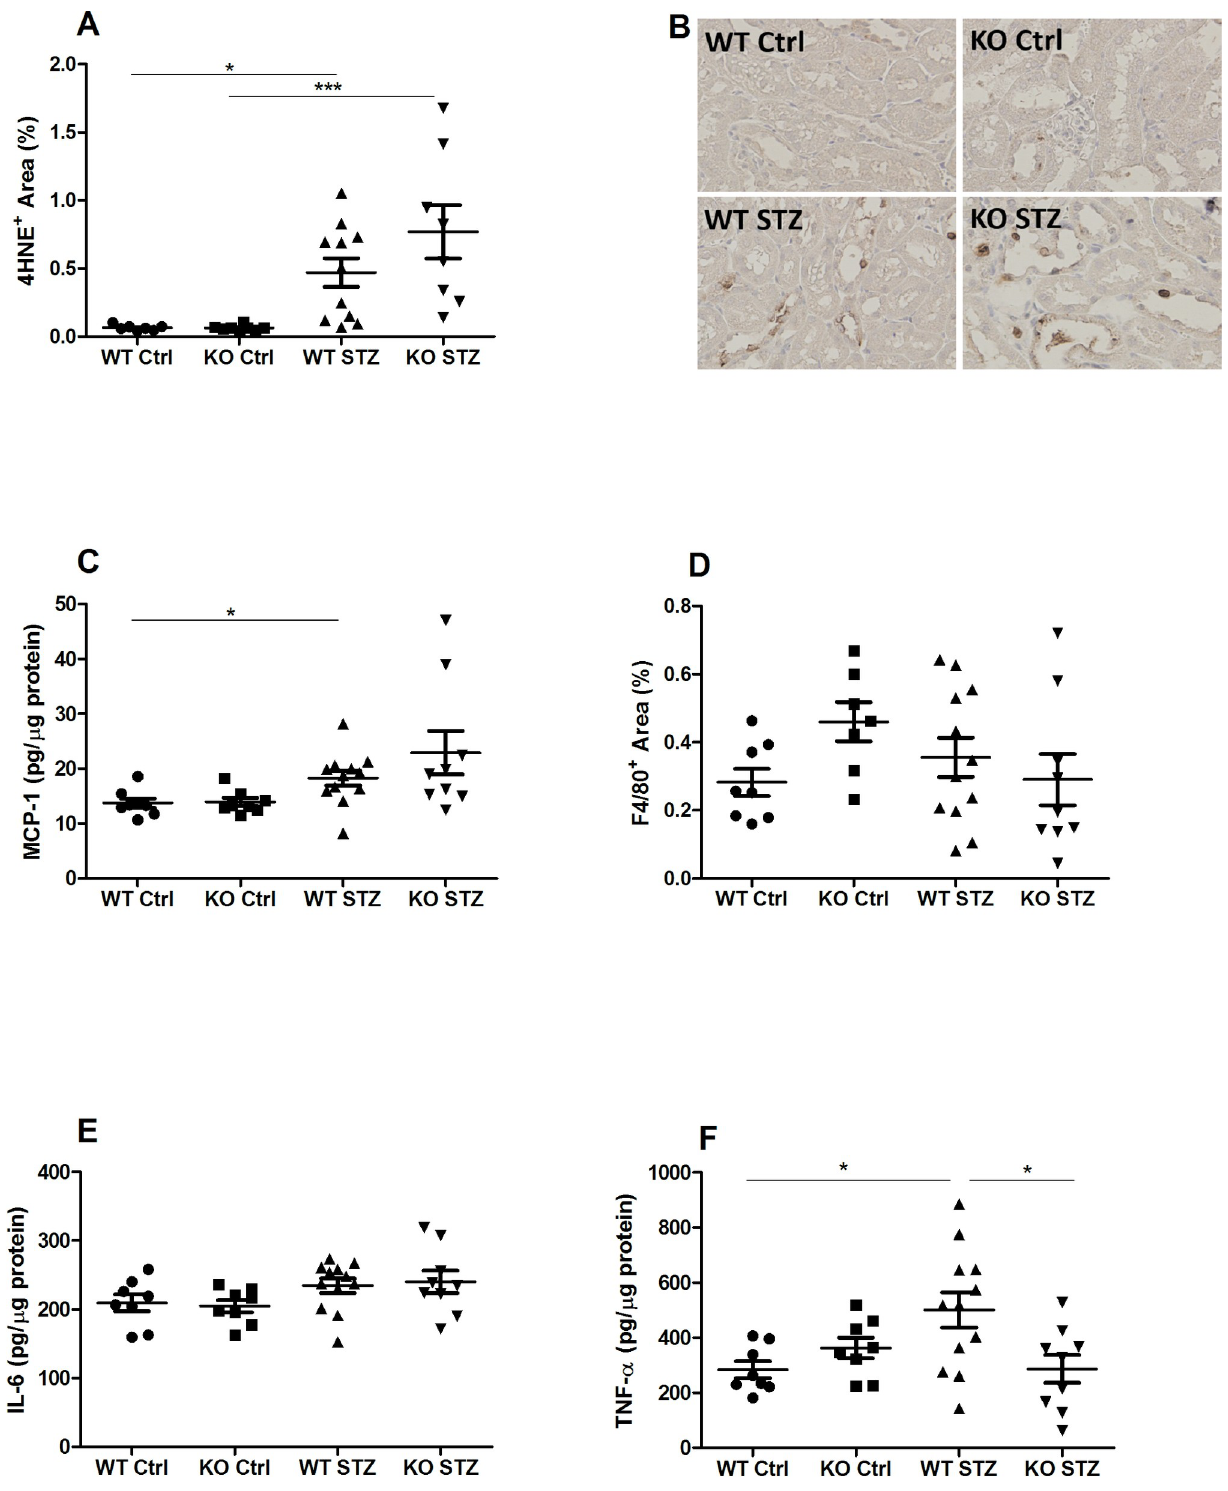
Fig 4. Oxidative stress and inflammation: 4-HNE, F4/80, MCP-1, IL-6, and TNF- α . (A) Quantification of the 4HNE staining in renal tissue. (B) Representative photos of the 4HNE staining (40x magnification). (C) MCP-1 protein expression in kidney homogenate measured by ELISA. (D) Quantification of F4/80 staining for cortical renal macrophages. (E-F) Expression of pro-inflammatory cytokines IL-6 and TNF- α measured by ELISA in kidney homogenate. Data shown as mean ± SEM. � p < 0.05, �� p < 0.01, ��� p < 0.001. 4HNE = 4-hydroxynonenal; MCP-1 = Monocyte chemoattractant protein 1; F4/80 = macrophage marker; IL-6 = Interleukin-6; TNF- α = Tumor necrosis factor alpha.